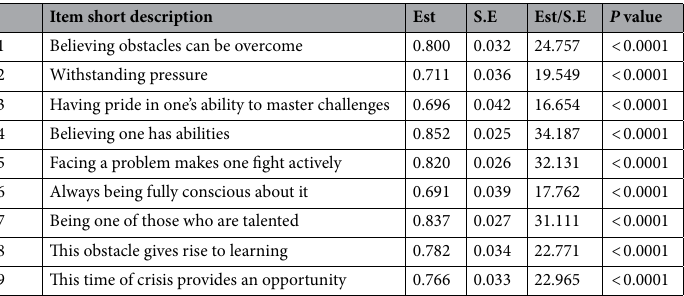
Table 3. Confirmatory factor analysis results for the RI-9. Est = Estimated coefficients, SE = standard error, Fit statistics showed Chi-square = 39.717, df = 23, p = 0.017, CFI = 0.995, TLI = 0.992, RMSEA 0.056 (90% CI 0.024–0.085), SRMR =